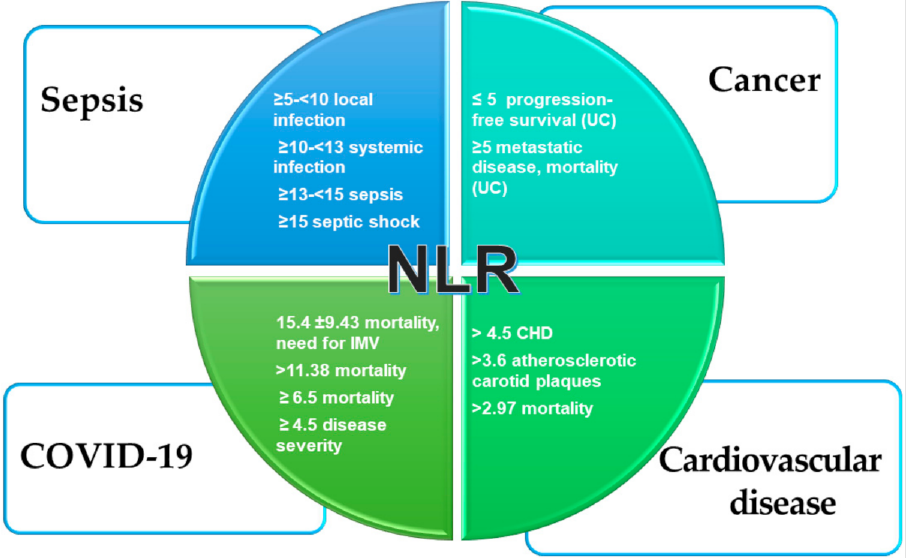
Figure 1. Reported NLR cut-off values and diseases. IMV, invasive mechanical ventilation; CHD, coronary heart disease; UC, urothelial